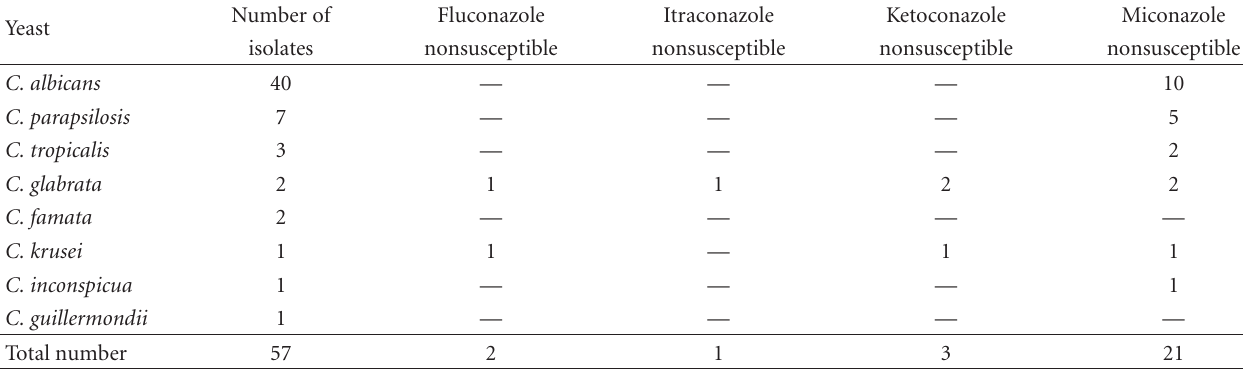
Table 2: Azole nonsusceptibility of Candida isolates from vagina of women with or without vulvovaginitis and with previous miconazole treatment. Total number of isolates =